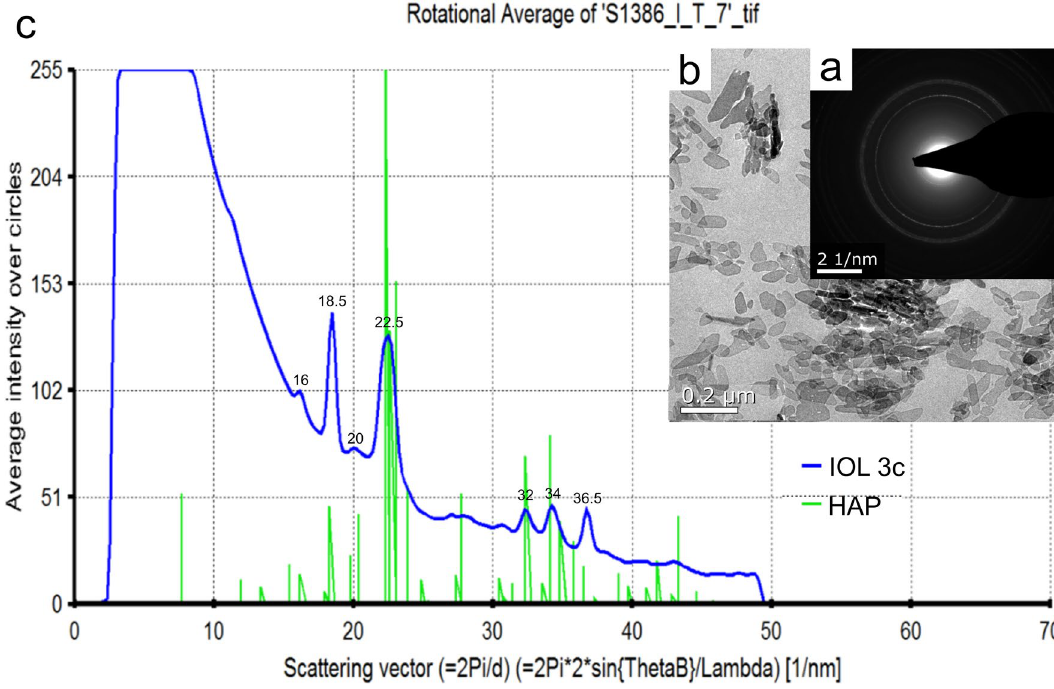
Figure 6. Electron crystallography of crystals within the polymer of IOL 3c. Transmission electron microscopy ( b ) provides the electron diffraction (ED) pattern of the crystals ( a ). Comparison ( c ) of the crystals’ ED pattern within IOL 3c to a reference ED of hydroxyapatite (HAP) shows a very high accordance: The ED of IOL 3c shows peaks at a scattering vector of 16, 18.5, 20, 22.5, 32, 34 and 36.5, characteristic for